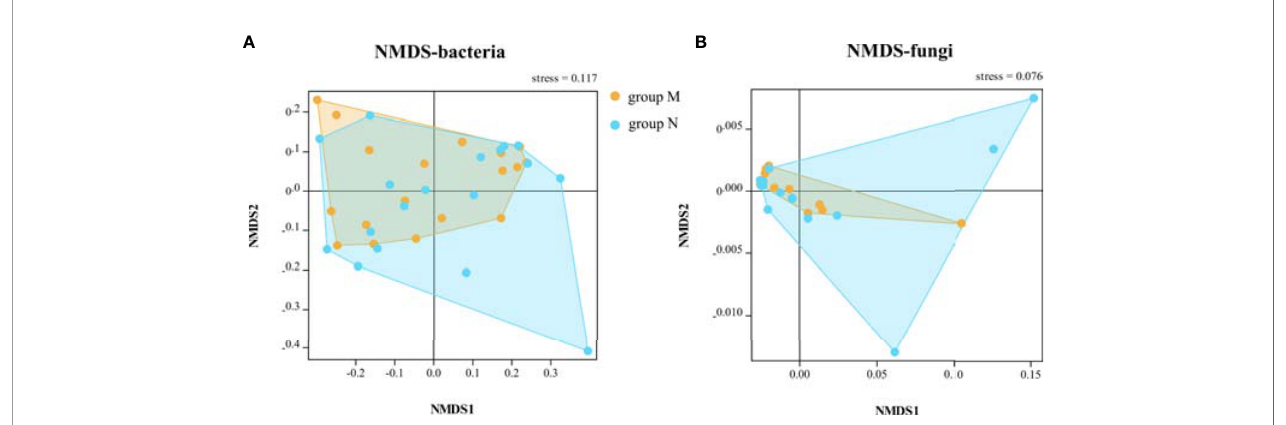
FIGURE 4 | The non-metric multi-dimensional scaling (NMDS) analysis based on Bray – Curtis of bacterial ( A , at family level) and fungal ( B , at phylum level) communities before and after